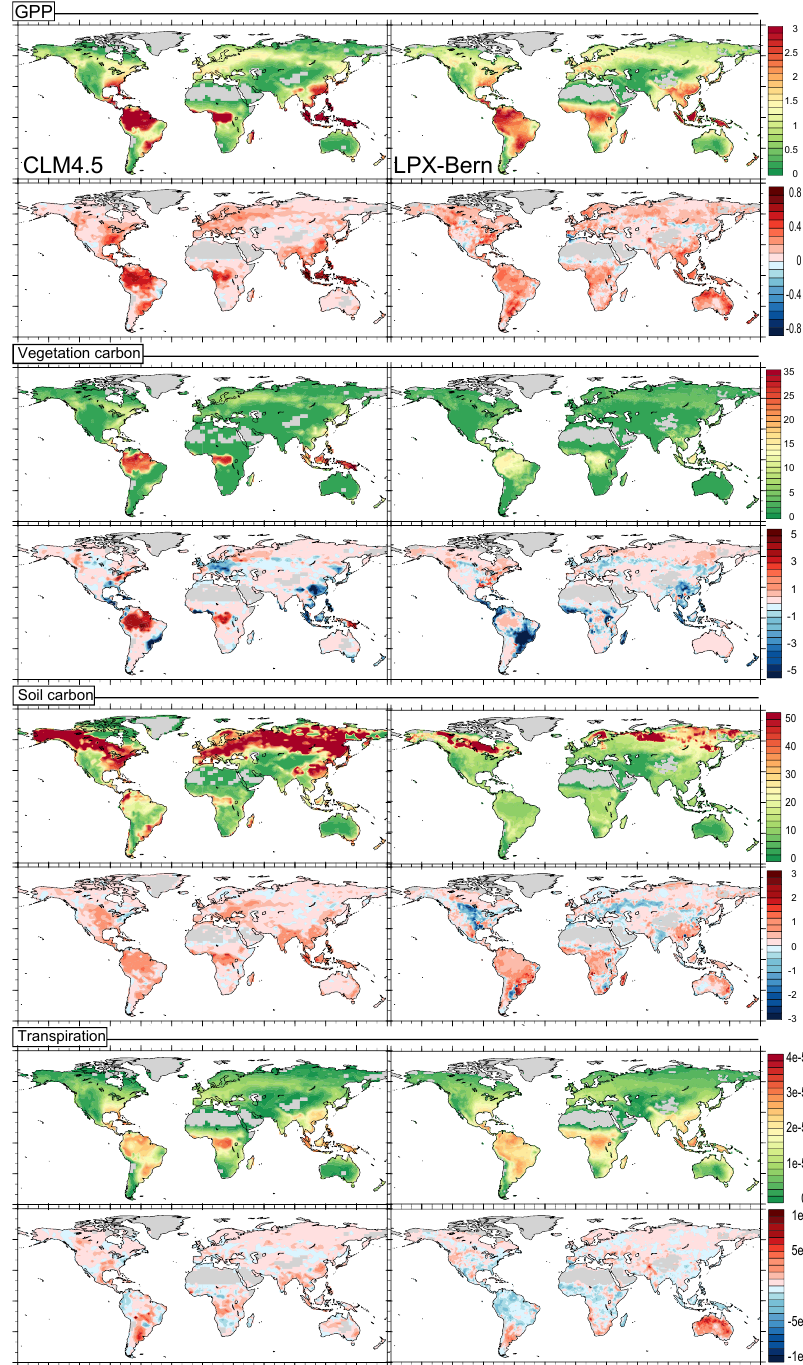
Figure 2. GPP (kgCm − 2 yr − 1 ), vegetation carbon (kgCm − 2 ), soil carbon (kgCm − 2 ), and transpiration (mms − 1 ) in the year 2000 (top) and the difference between 1900 and 2000 (below). The estimates are based on decadal means (1996–2005 and 1996–2005 minus